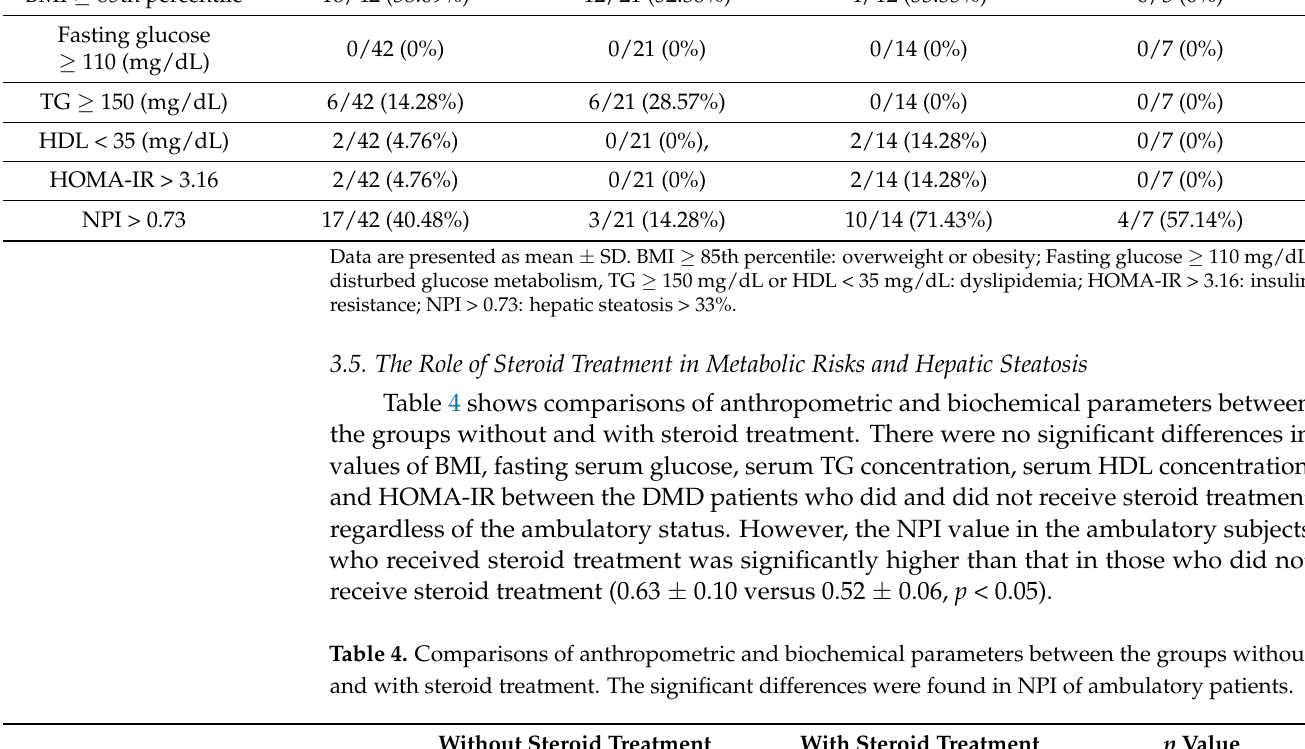
Table 3. The percentage of each parameter of metabolic risk and hepatic steatosis in our DMD cohort. Two thirds of the non-ambulatory DMD patients had moderate to severe hepatic steatosis. No. of Subjects Who No. of Subjects Who No. of Subjects Who No. of Subjects Who Fulfill the Fulfill the Fulfill the Criteria/No. Fulfill the Criteria/No. Criteria/No. of Criteria/No. of of Ambulatory of Subjects (%) Subjects at Stage 3 (%) Subjects at Stage 2 (%) Subjects (Stage 1) (%) 16/42 (38.09%) 12/21 (52.38%) 4/12 (33.33%)